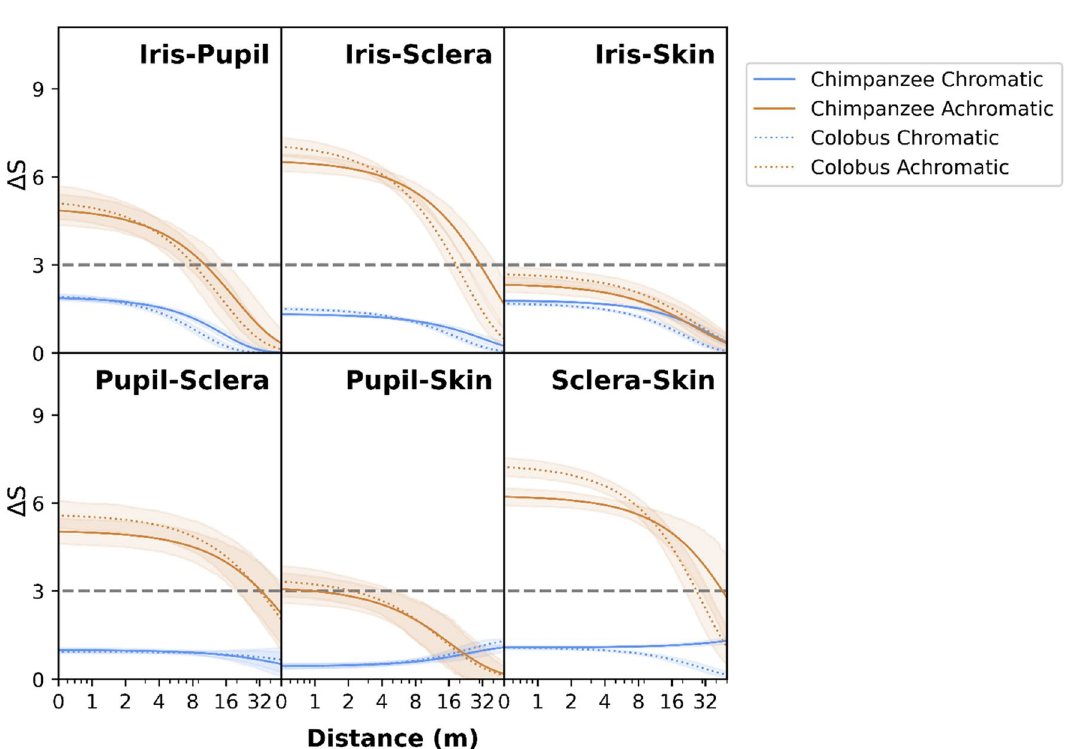
Figure 2. Chromatic and achromatic ∆S values for contrasts among the eye regions shaded in the top-right inset. A ∆S value greater than 3 at some distance suggest that the two ROI can be discriminated from each other. Shaded regions around lines are Bayesian 94% Highest Posterior Density intervals around ∆S estimates. Tick intervals on the x-axis are